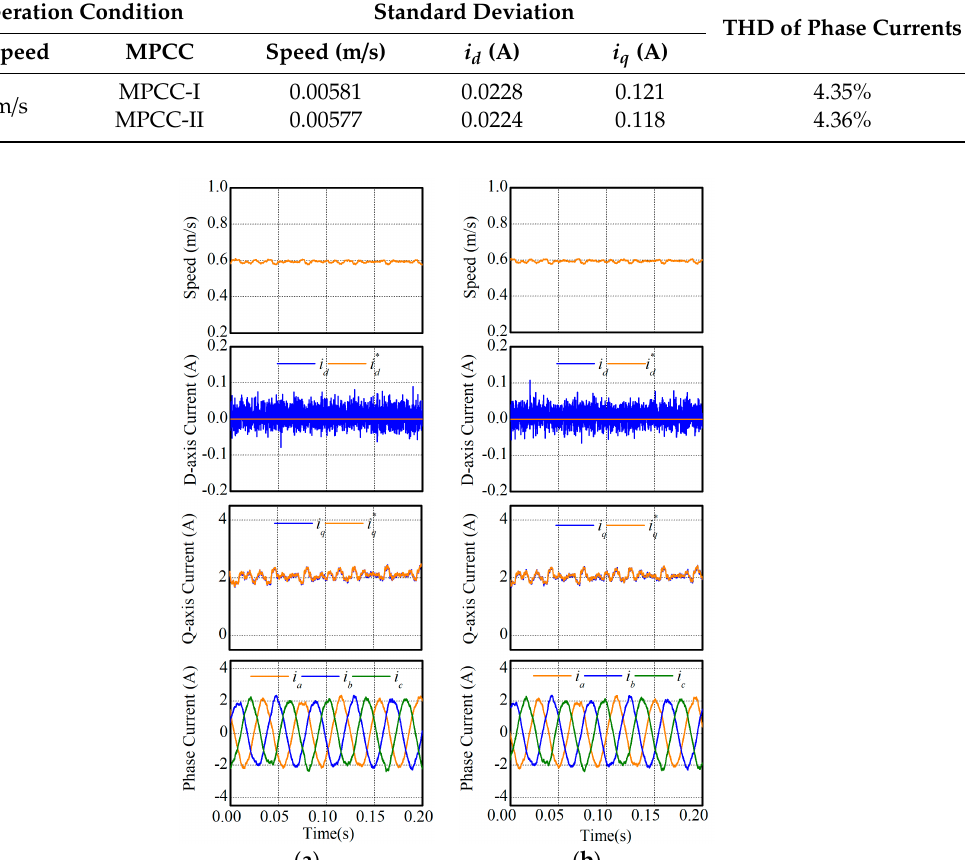
Figure 14. Steady-state performances with inaccurate mover resistance: ( a ) MPCC-I and ( b )